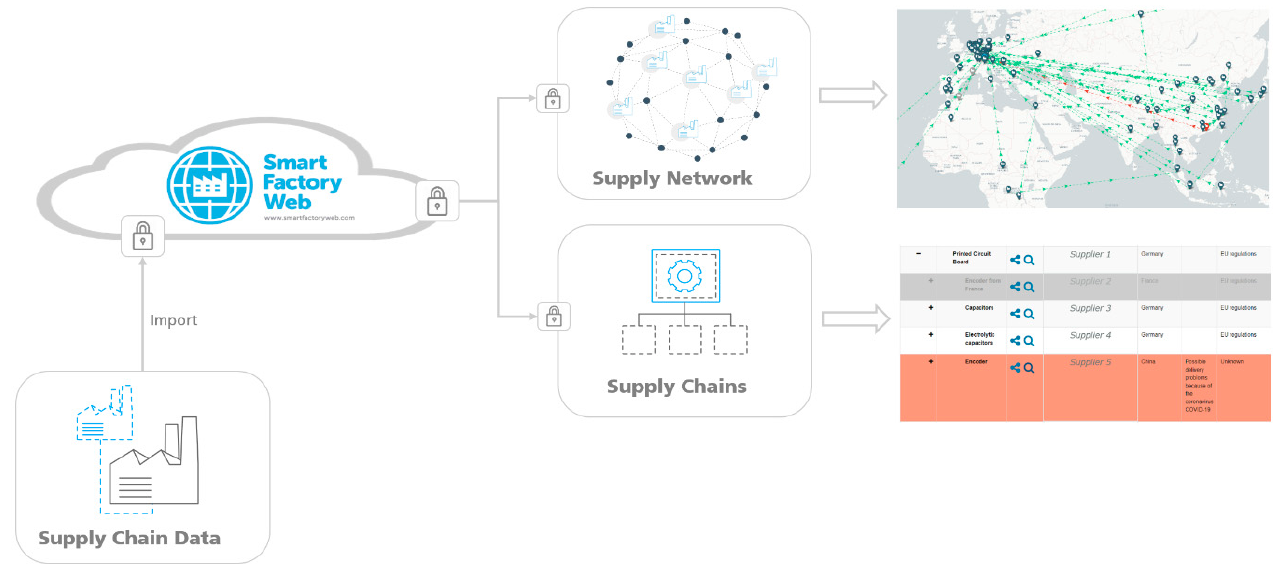
Figure 13. Smart Factory Web supply chain interface.